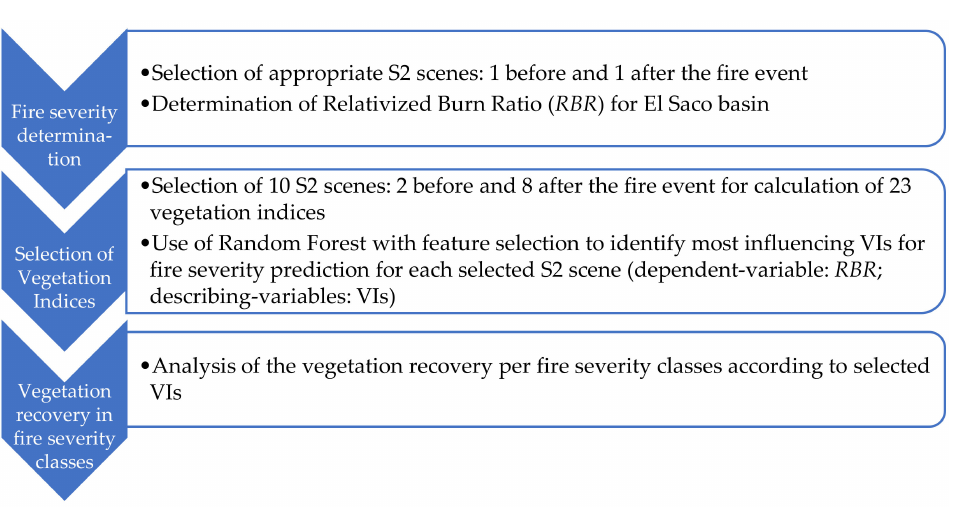
Figure 2. Workflow of the analysis of vegetation recovery at each fire severity class in the temperate (Cfb) zone in northern South